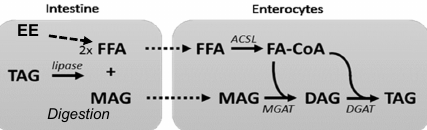
Figure 1. Digestion of fat and re-synthesis in the enterocyte for efficient chylomicron formation and systemic absorption in erythrocytes. Ethyl ester (EE), acyl-CoA synthetase long-chain (ACSL), Di-Acyl Glycerol (DAG), Monoacylglycerol acyltransferase (MGAT), Diglyceride acyltransferase (DGAT); Fatty Acid CoA (FA-CoA).